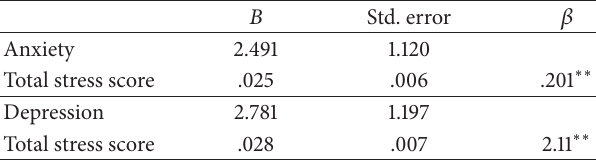
Table 4: Stress as a predictor of